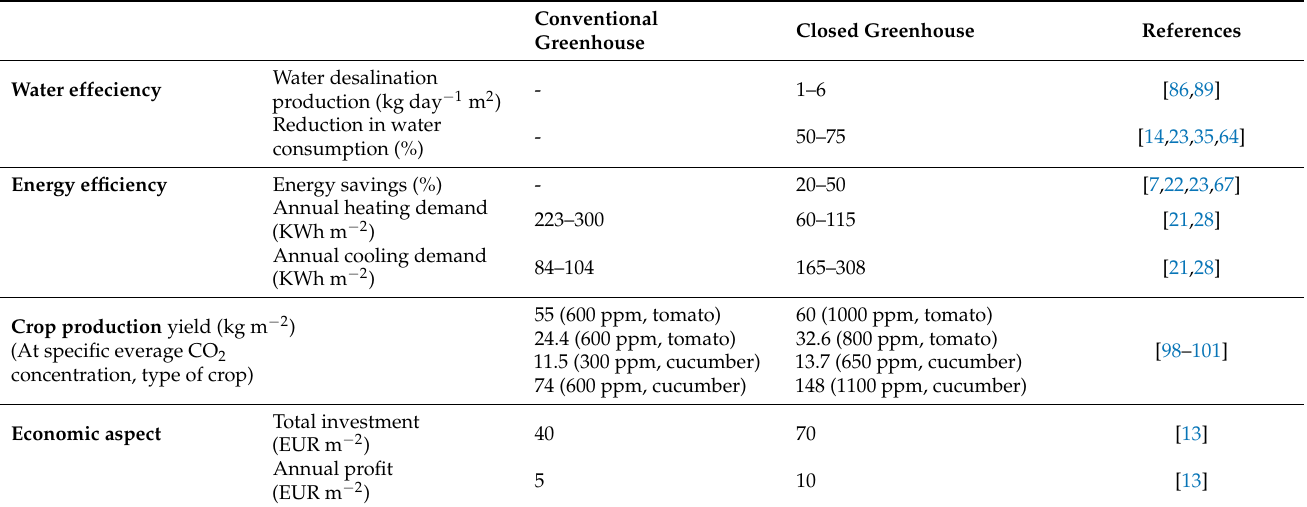
Table 5. Main advantages of closed greenhouses, compared to conventional greenhouse systems. Conventional Closed Greenhouse